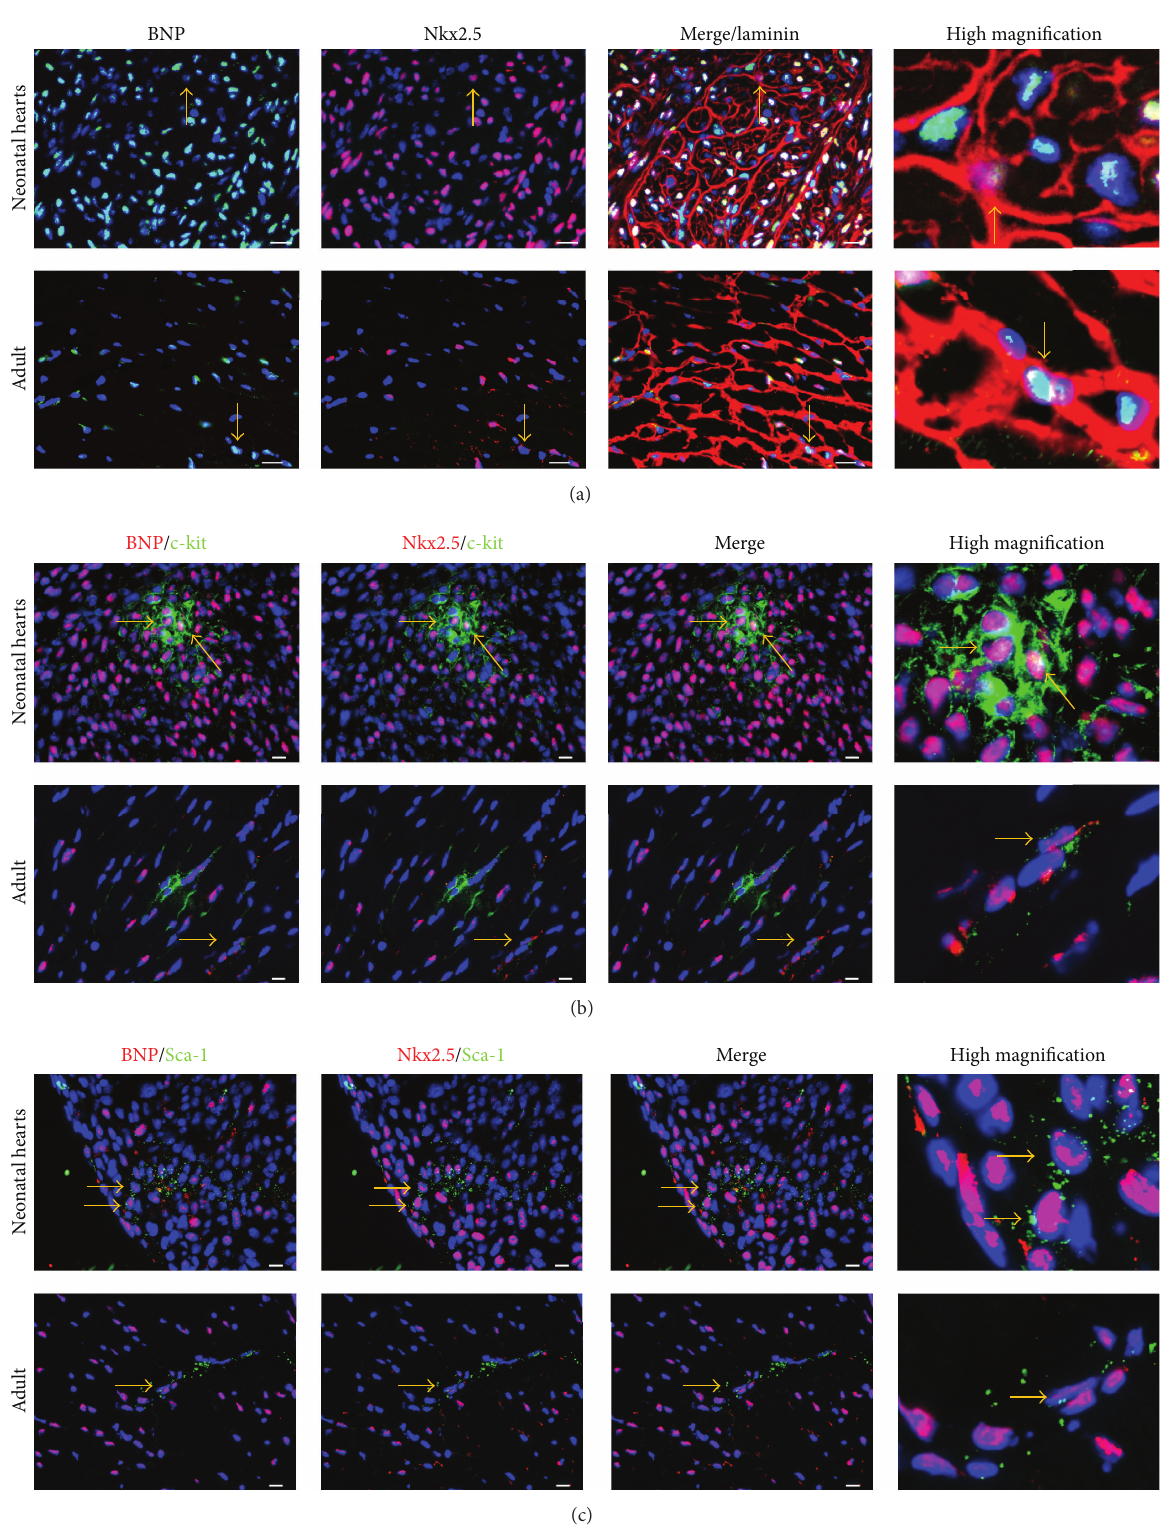
Figure 4: Cardiac precursor cells express BNP in neonatal and adult murine hearts. Cardiac precursor cells were defined as small Nkx2.5 +